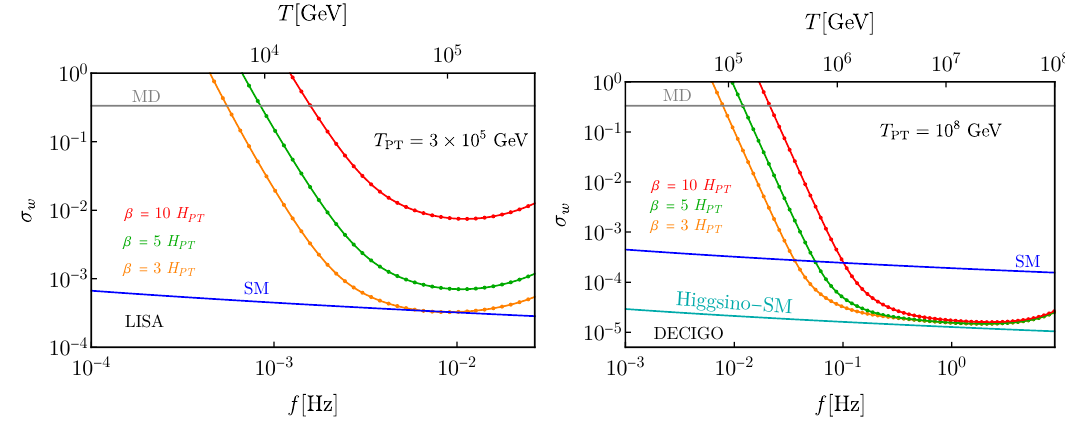
Figure 4 . The projected sensitivity, calculated using the Fisher matrix, of LISA (left) and DECIGO (right) to the equation of state near w = 1 / 3 as a function of frequency for various T PT . The sensitivity was obtained by binning the data logarithmically between a frequency f 0 and f 0 / 3 .